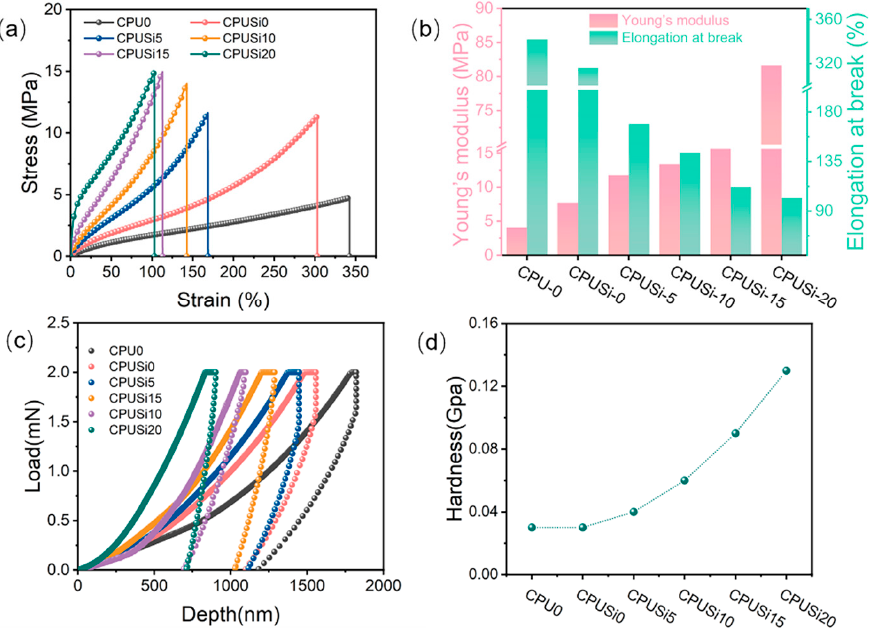
Figure 9. ( a ) Strain–stress curves; ( b ) Tensile properties; ( c ) Load-displacement curves; ( d ) Hardness values of CPU and CPUSi hybrids films.